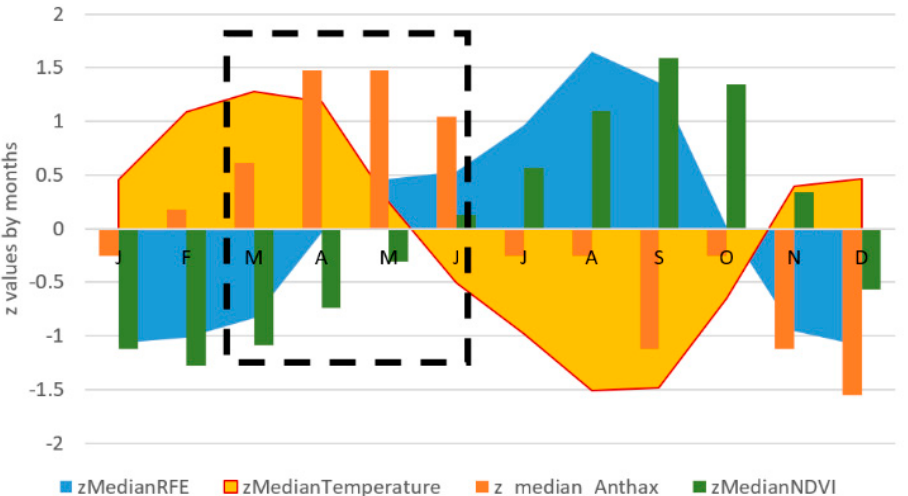
Figure 4. Periodicity of the standardized median number of anthrax outbreaks (z_median_Anthrax; orange bar), rainfall (zMedianRFE; blue area), NDVI (zMedianNDVI; green bars) and temperature (zMedianTemperature; yellow area) by month in the study area. The inset shows that the peak in anthrax outbreaks occurs between April and May, when the temperature decreases while rainfall and NDVI increase.